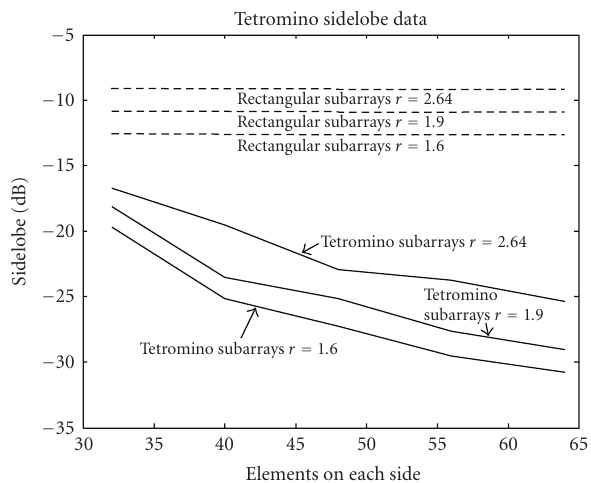
Figure 12: Peak sidelobe level of rectangular and L-tetromino subarrays r = f/ f 0 = 1.6 (moderate bandwidth), r = 1.9 and r = 2.64 (wide band).